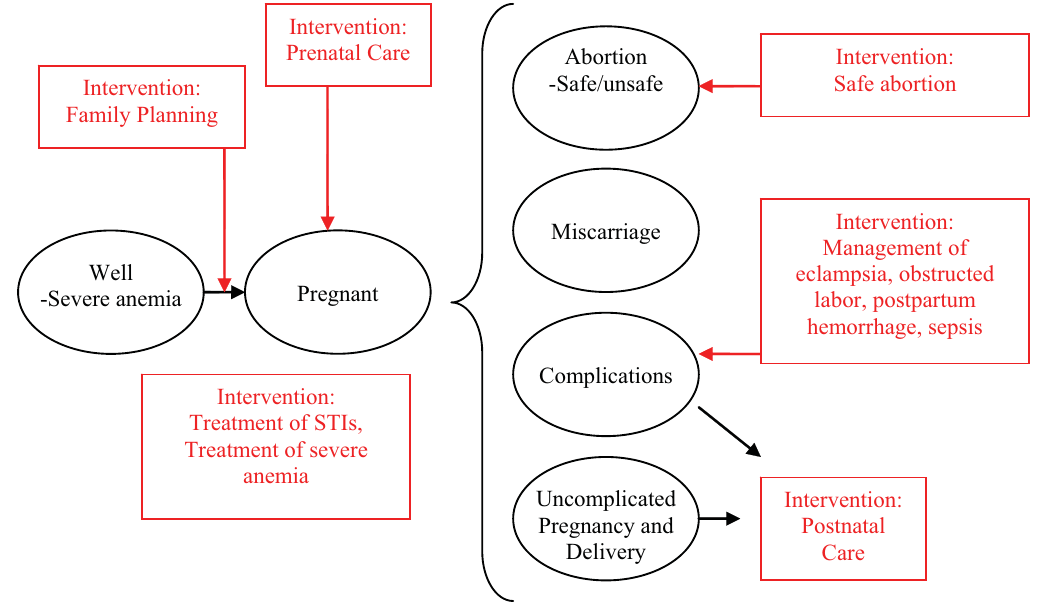
Figure 2. Schematic of Modeled Interventions. Interventions are applied to different points along the clinical course of pregnancy and delivery. Prenatal care, the treatment of sexually transmitted infections, and the management of severe anemia apply throughout the three trimesters of pregnancy prior to labor and delivery. Safe abortion applies to the first trimester of pregnancy. Hospital-based interventions such as the management of severe preeclampsia/eclampsia, obstructed labor, postpartum hemorrhage, and sepsis apply to the periods of labor and delivery as well as postpartum.